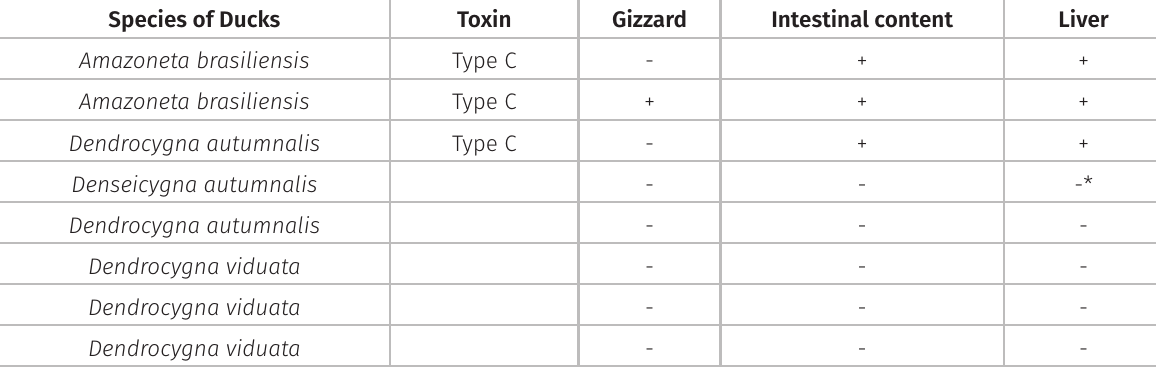
*The samples marked in red contained botulinum toxin to provoke symptoms in mice but without causing death. By the technique, they are considered negative types even having been neutralized by the anti-toxin